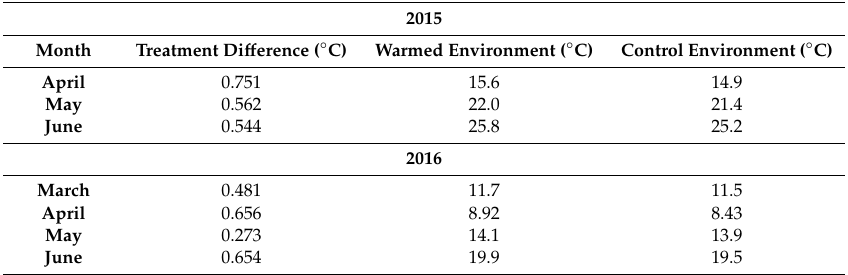
Table 2. Average monthly nighttime canopy temperatures and di ff erence among environments in passively warmed and control environments, 2015–2016 season, Lexington KY. Sampling interval: 15 min, 7:00 p.m.–7:00 a.m.